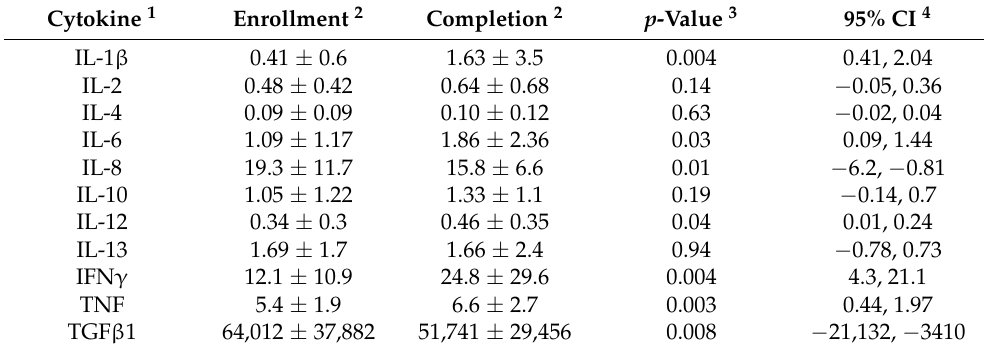
Table 2. Changes in infant plasma cytokine concentrations from study enrollment to completion.